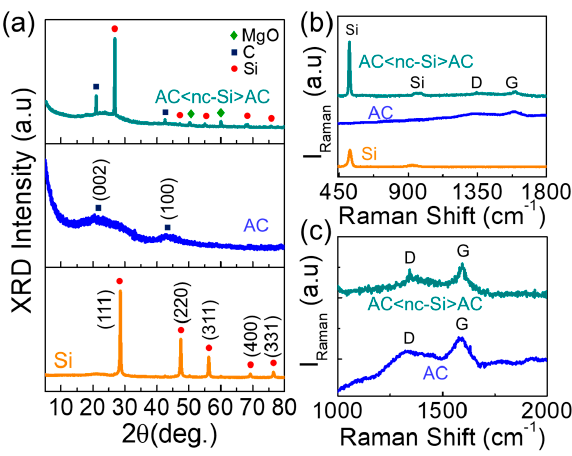
Figure 4. ( a ) X-ray di ff ractometry (XRD) patterns and ( b ) Raman spectra of nc-Si, AC, and AC < nc-Si > AC nanocomposites. ( c ) Highlighted view of the Raman spectra for AC and AC < nc-Si > AC